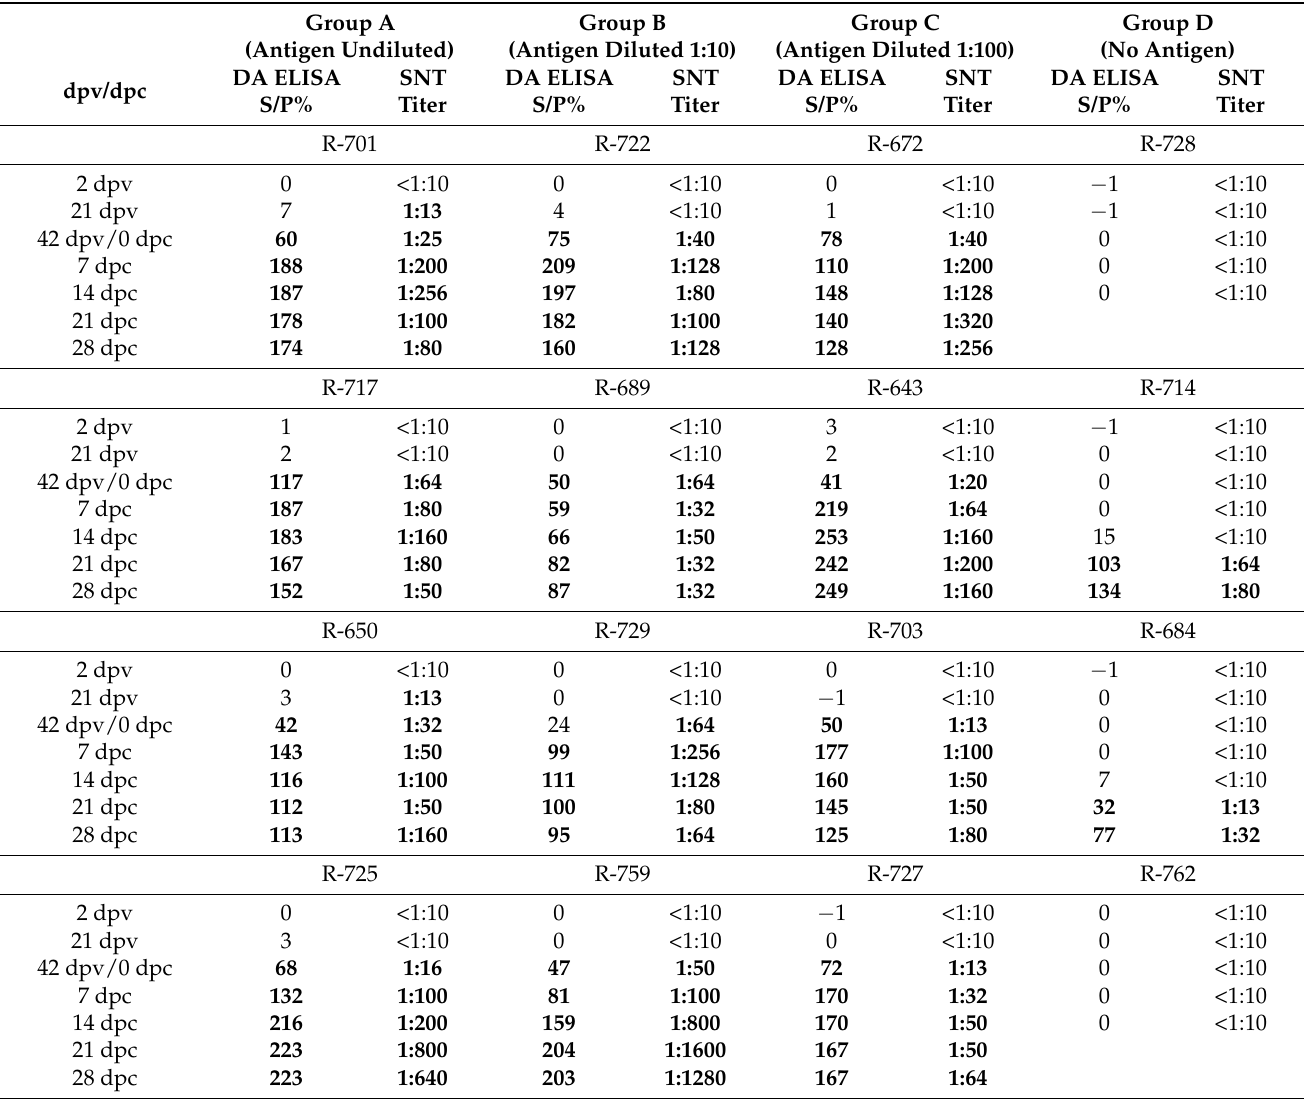
Table 1. Serological results of vaccinated and challenge control cattle on ELISA and SNT from − 2 dpv until 28 dpc (S/P% below 30 on ELISA and SNT titer < 1:10 was defined as negative; positive values are given in boldface for easier